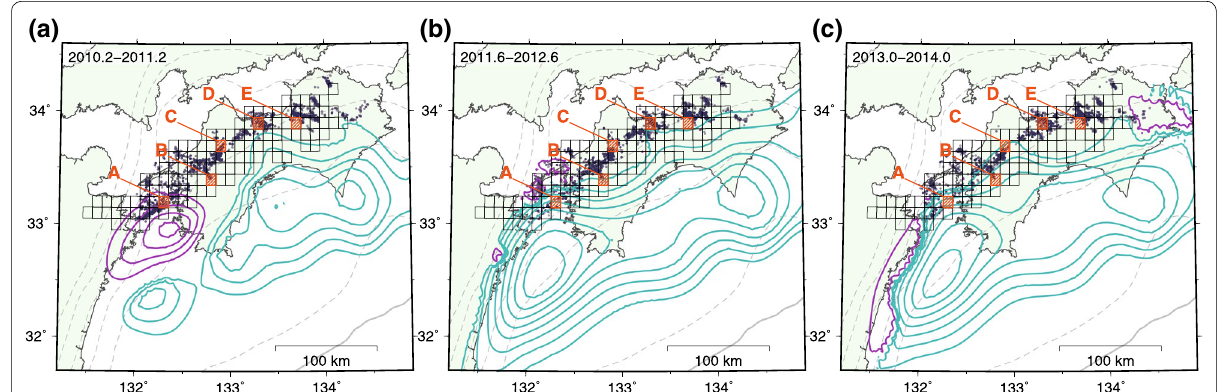
Fig. 2 Examples of coupling distributions (solid contours) at 3 of the 41 epochs with epicenters of tremor in the same epoch. a , b and c show the distributions in 2010.2-2011.2, 2011.6-2012.6, and 2013.0-2014.0, respectively. The blue and red contours represent the positive and negative coupling rates, respectively, and the negative coupling rates correspond to slow slips. Spacings of the contours are 1 and 3 cm/year for the positive and negative values, respectively. Blue dots denote the epicenters of the tremors, and black grids are used for analyzing the relation between the coupling and the tremor count rates. Grids A–E correspond to the results that are depicted in Figs. 3 and